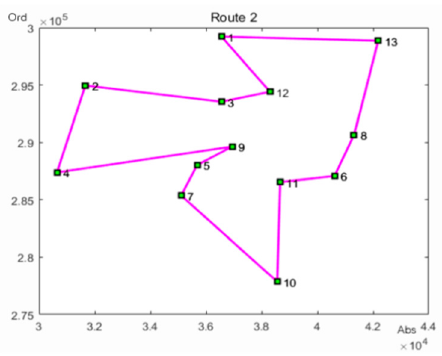
Figure 3. Delivery order of second courier.